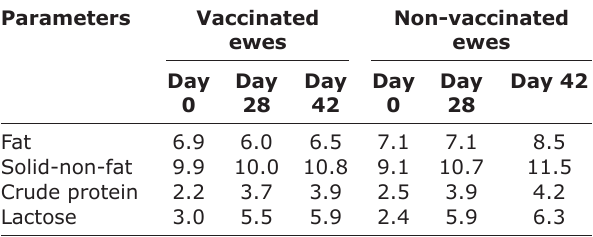
Table-3: Percentages of various milk composition parameters in vaccinated and non-vaccinated normal